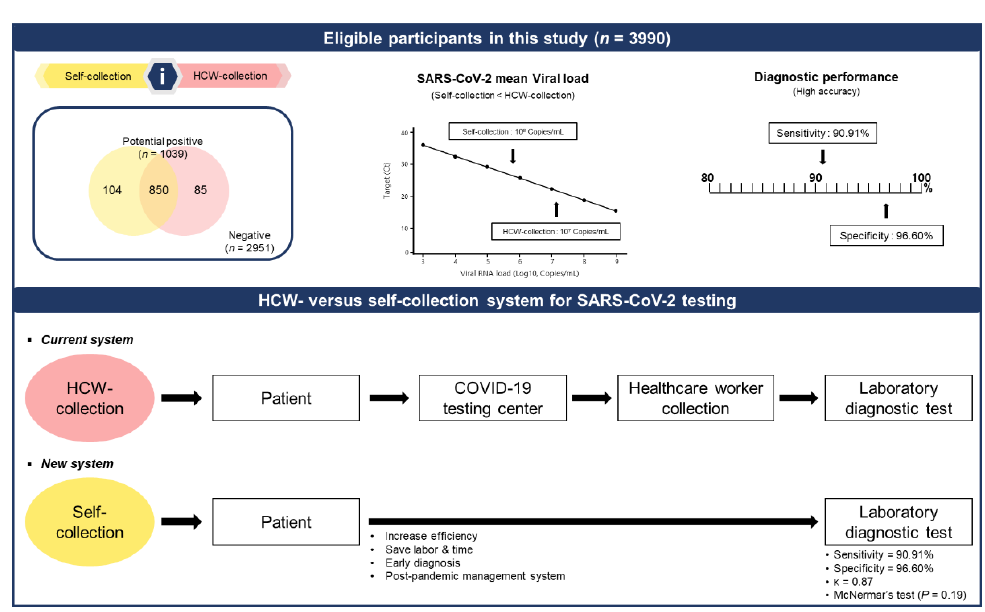
Figure 4. Summary of clinical performance and contribution of the self-collection system. Supplementary Materials: The following are available online at